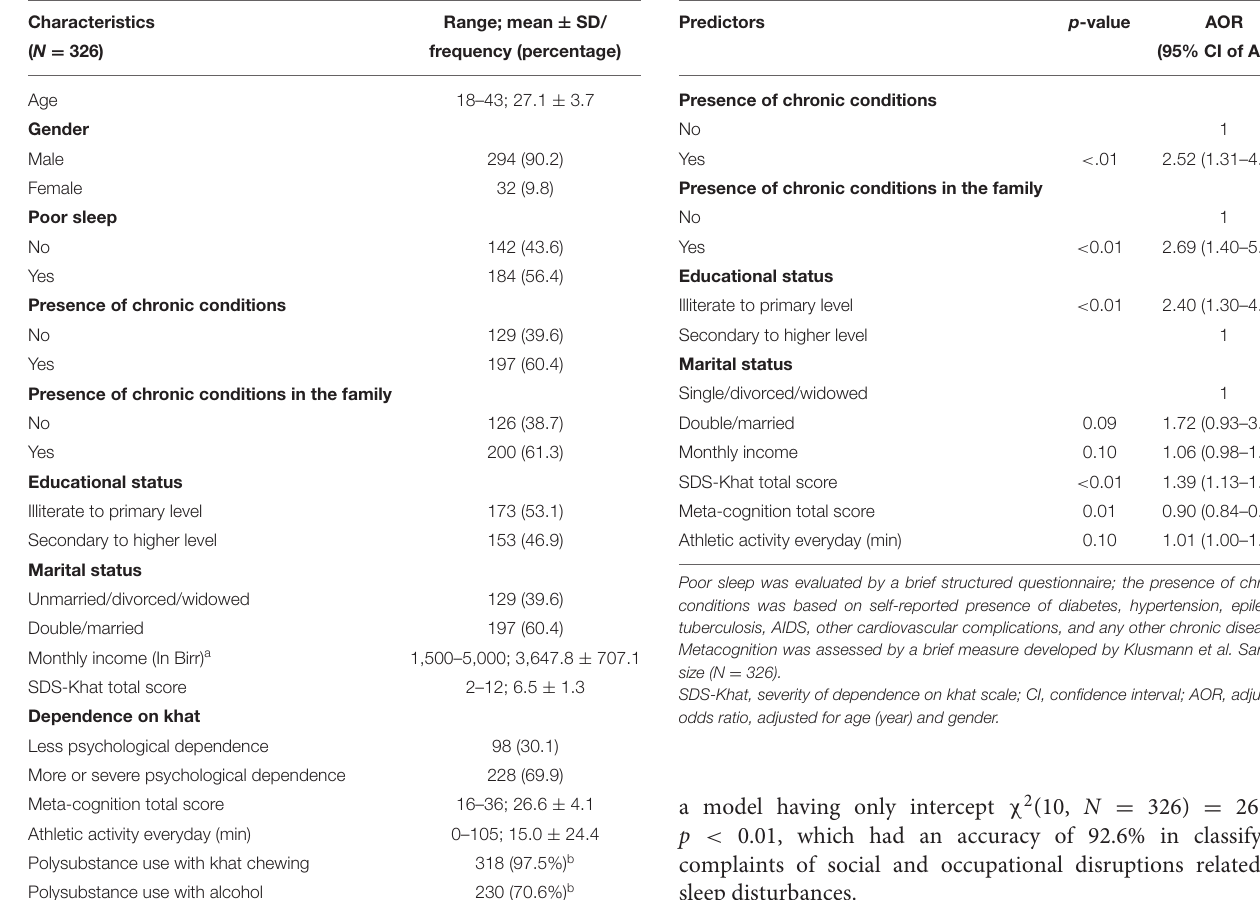
TABLE 1 | Participants’ characteristics. TABLE 2 | Logistic regression predicting poor sleep in polysubstance